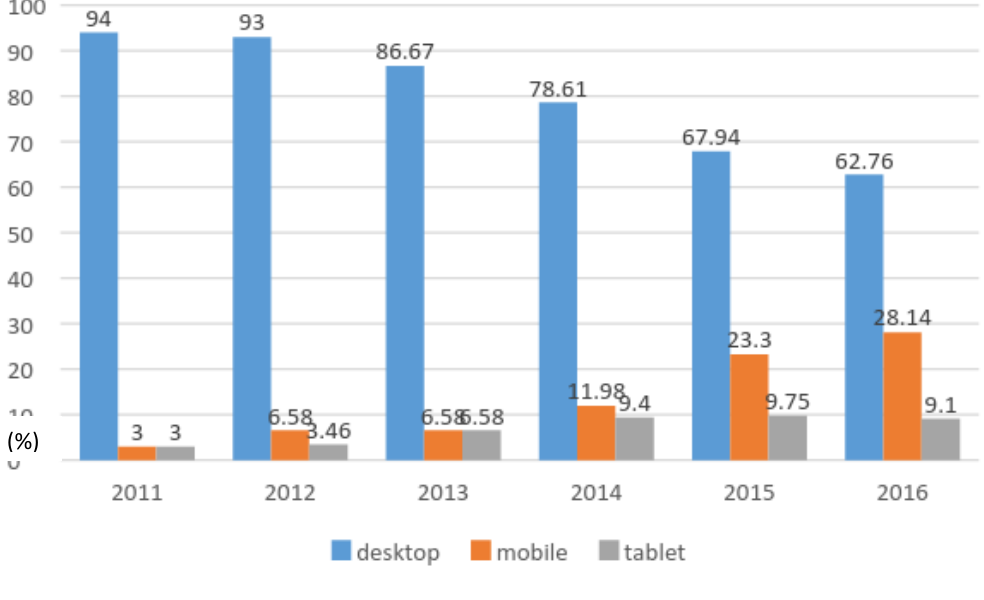
Figure 7. Devices NTU OCW users use to access the